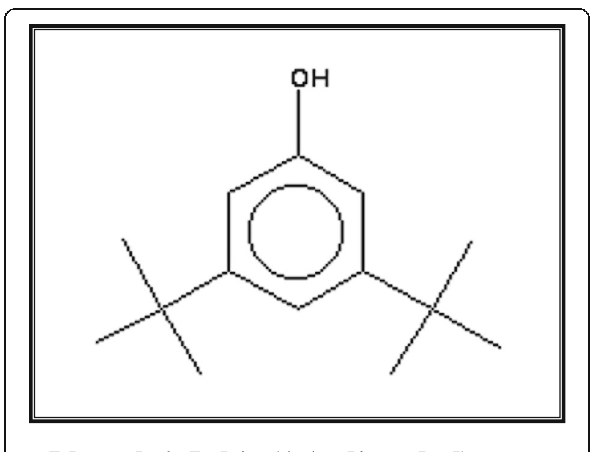
Fig. 5 Isolated compound from methanolic extract of Praecitrullus fistulosus